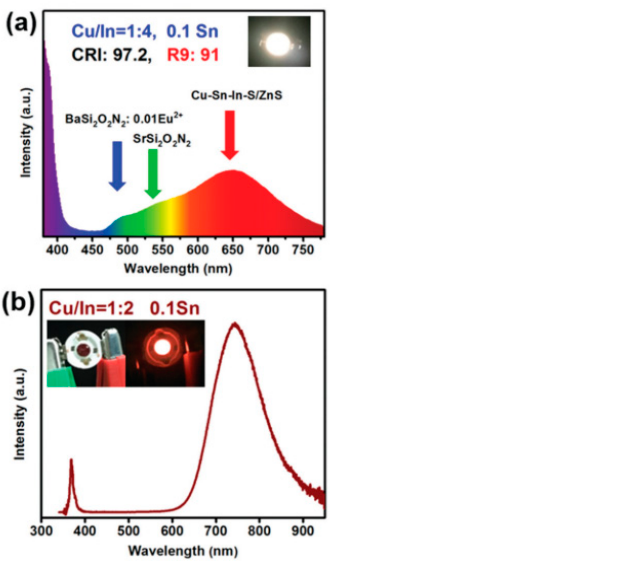
Figure 17. Electroluminescence (EL) spectra of ( a ) white light emitting diode (wLED) and ( b ) NIR LED devices combined with CTIS/ZnS QDs (0.1 mmol Sn) with the Cu/In molor ratios of 1/4 and 1/2, respectively. Reproduced with permission from [209]. Copyright RSC, 2018.